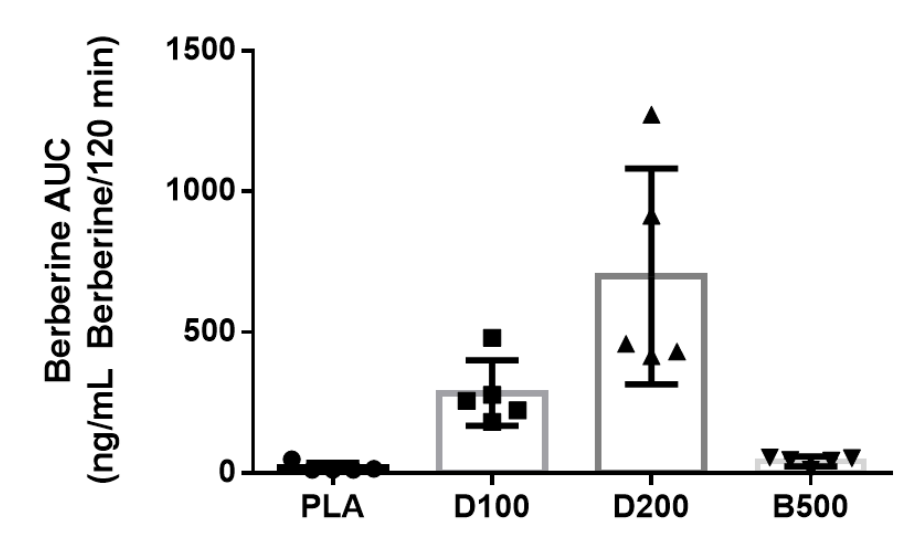
Figure 3. Individual and aggregated mean values for berberine AUC by condition. Each individual symbol represents the individual AUC response for one study partici- pant. For all graphs below, n = 5 participants completed each condition. PLA = Placebo; D100 = 100 mg dose of dihydroberberine; D200 = 200 mg dose of dihydroberberine; B500 = 500 mg dose of berberine. Data are presented as mean ± SD.